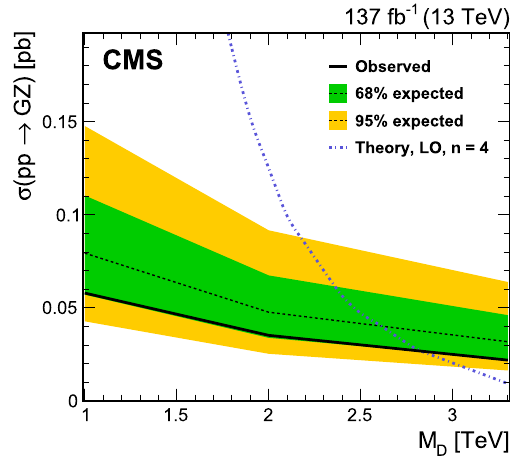
Fig. 11 The 95% CL cross section limit in the ADD scenario as a function of M D for n = 4